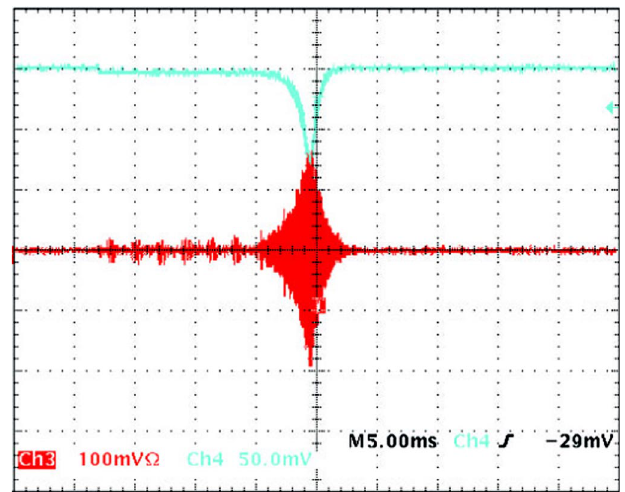
FIG. 2. (Color) A screen shot of an oscilloscope showing the HOM voltage (red) and power (blue) of the 2106.007 MHz HOM in cavity 7 of zone 3 during BBU.